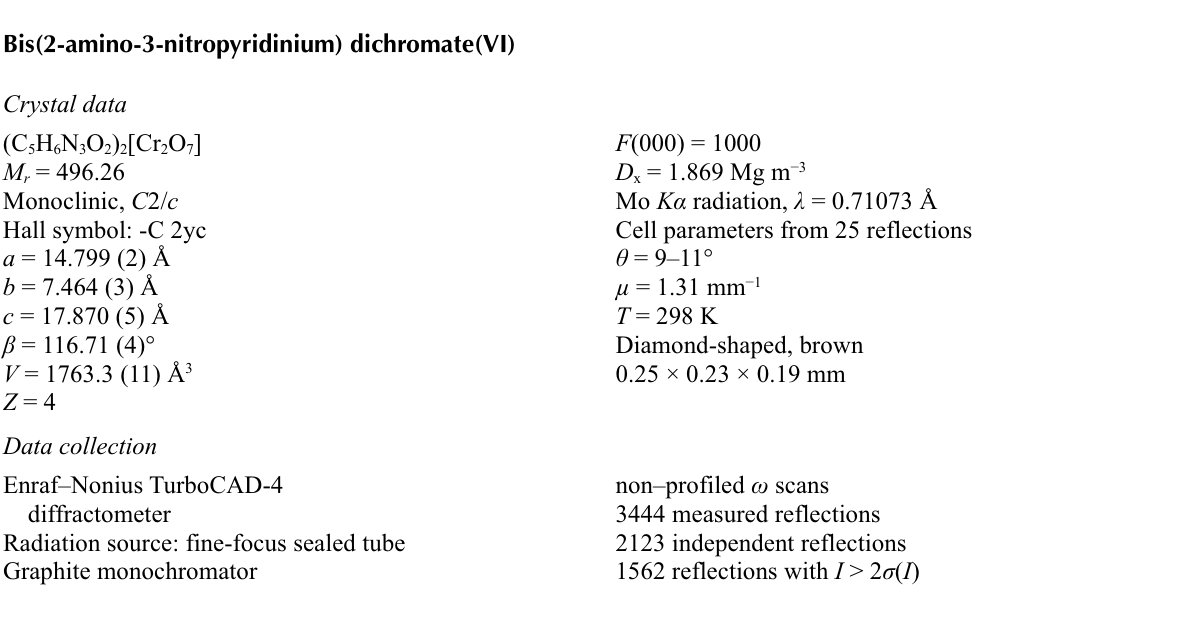
Figure 2 Projection of (I) along the b